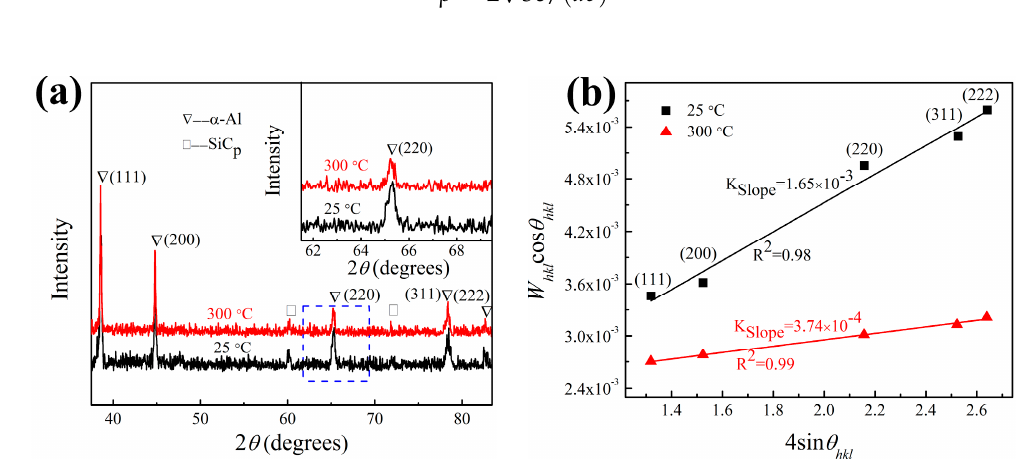
Figure 7. ( a ) XRD patterns and ( b ) Williamson ‐ Hall (WH) plots of the composite tested at different